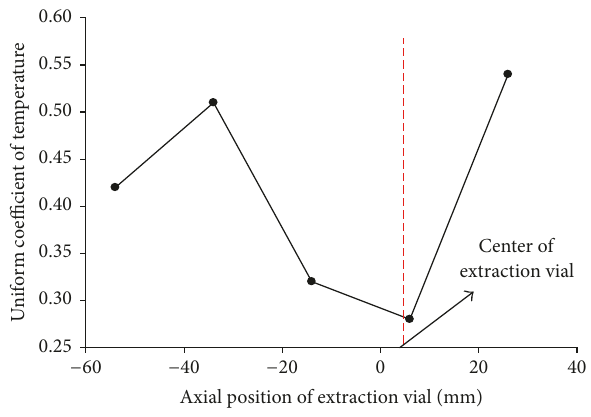
Figure 6: Uniform coefficient of temperature distribution along axial position of extraction vial (ethanol concentration of 60% and the ratio of solid to liquid of 1 :30).